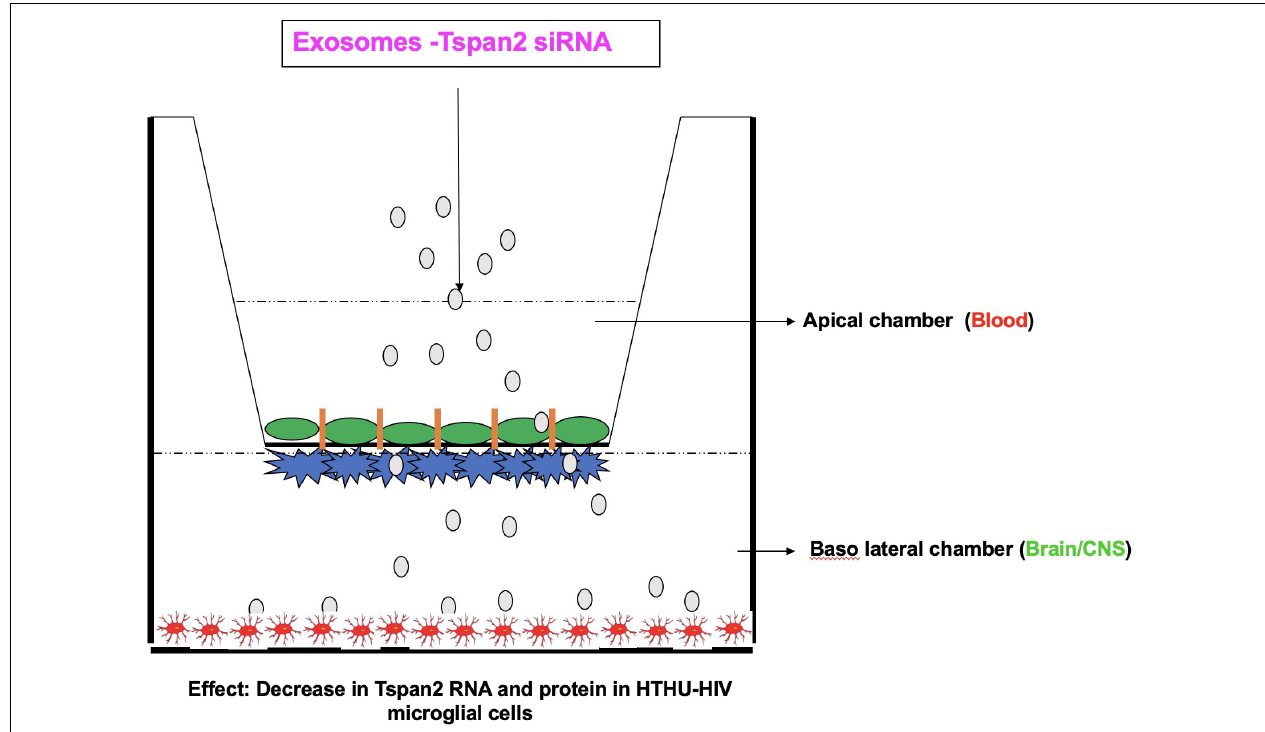
FIGURE 1 | Blood–brain barrier model demonstrating proof of concept of exosome delivery of Tspan2 across the BBB to latently infected microglia on the brain side. Schematic adapted from Reynolds and Mahajan (2020).